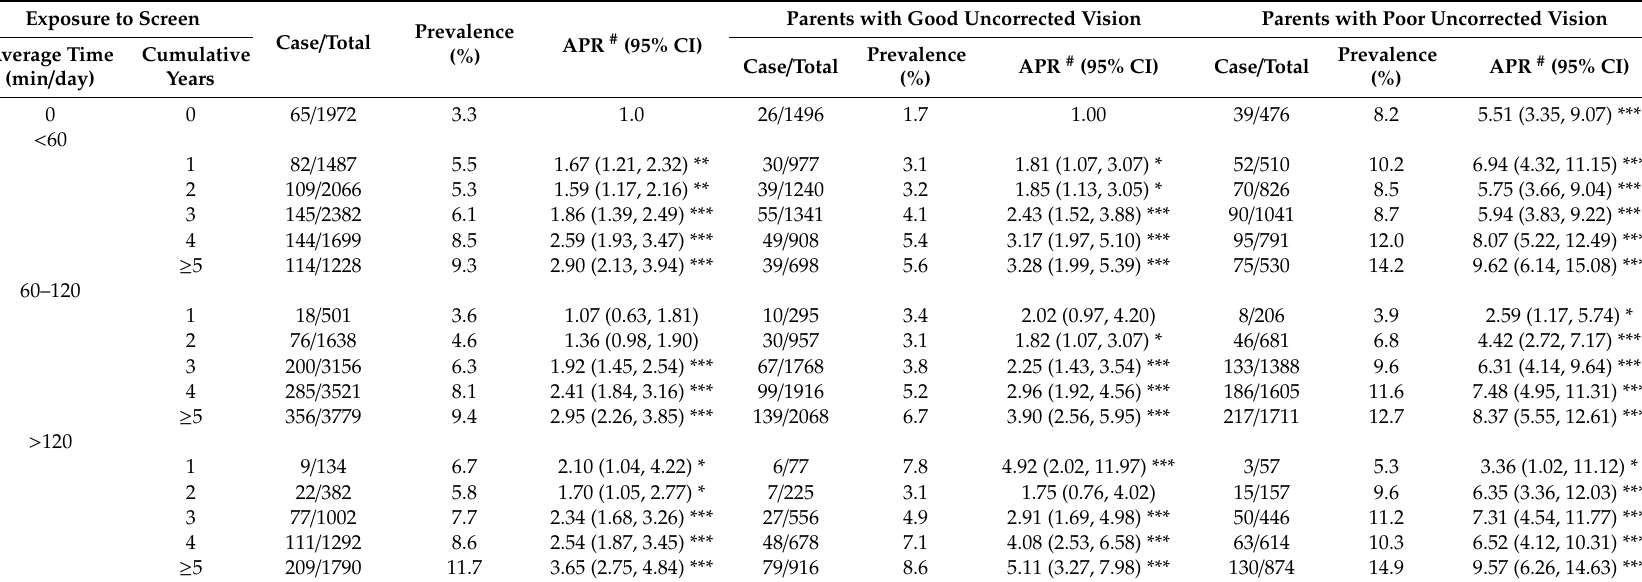
Table 3. Associations between the total years of exposure and preschool astigmatism grouped by average daily screen